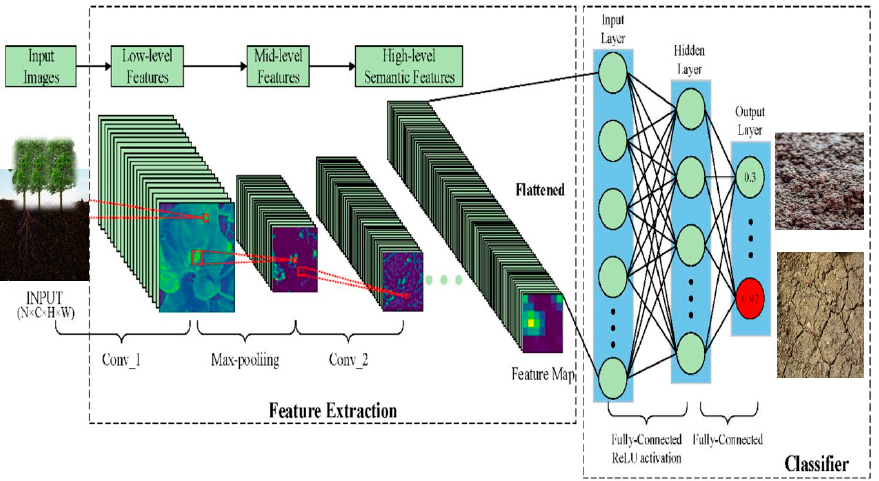
Figure 2. A CNN with N Inputs for precision